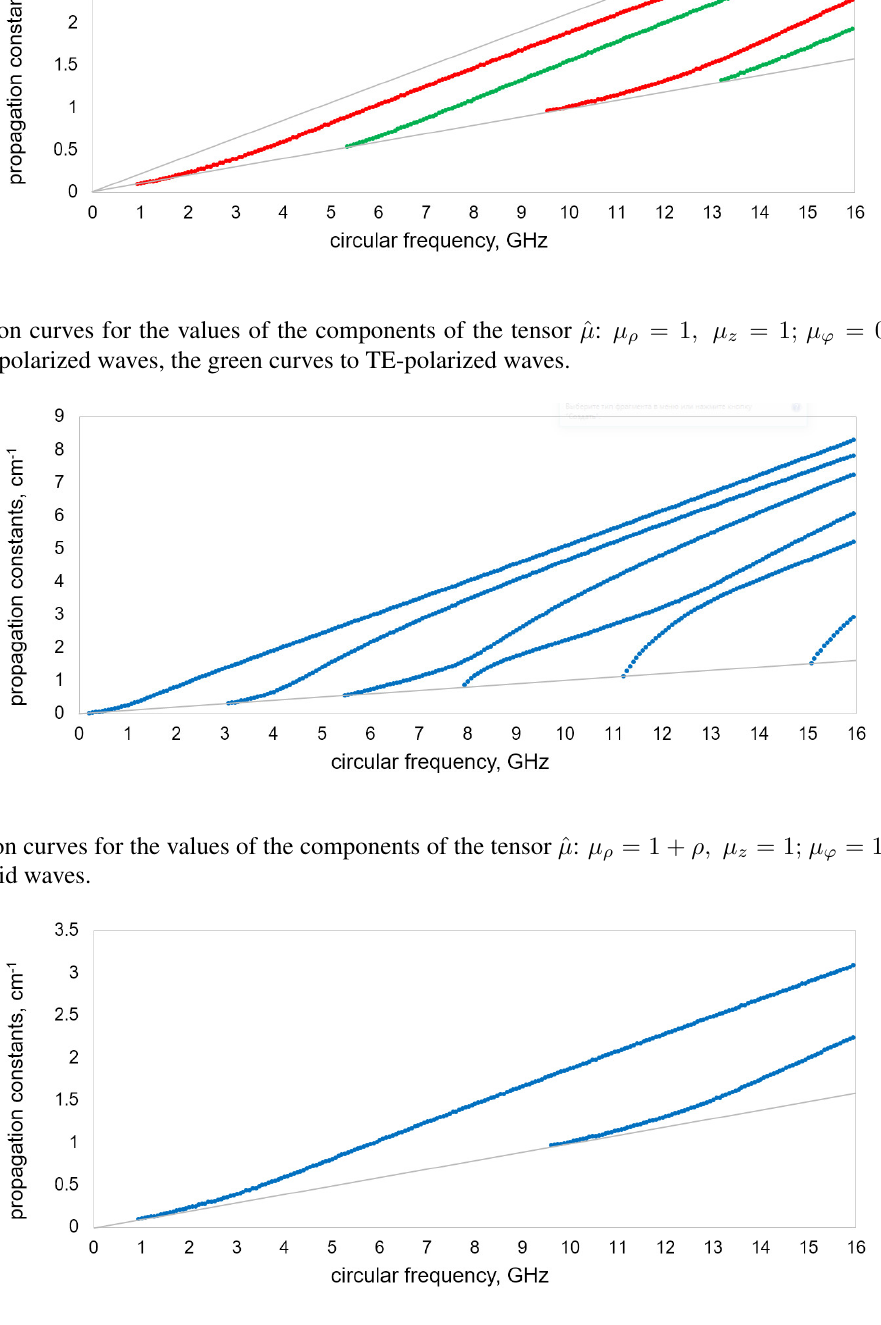
Figure 4: Dispersion curves for the values of the components of the tensor ^ (cid:22) : (cid:22) (cid:26) = 1 ; (cid:22) z = 1 + (cid:26) ; (cid:22) φ = 0 : 125 . The blue curves correspond to hybrid